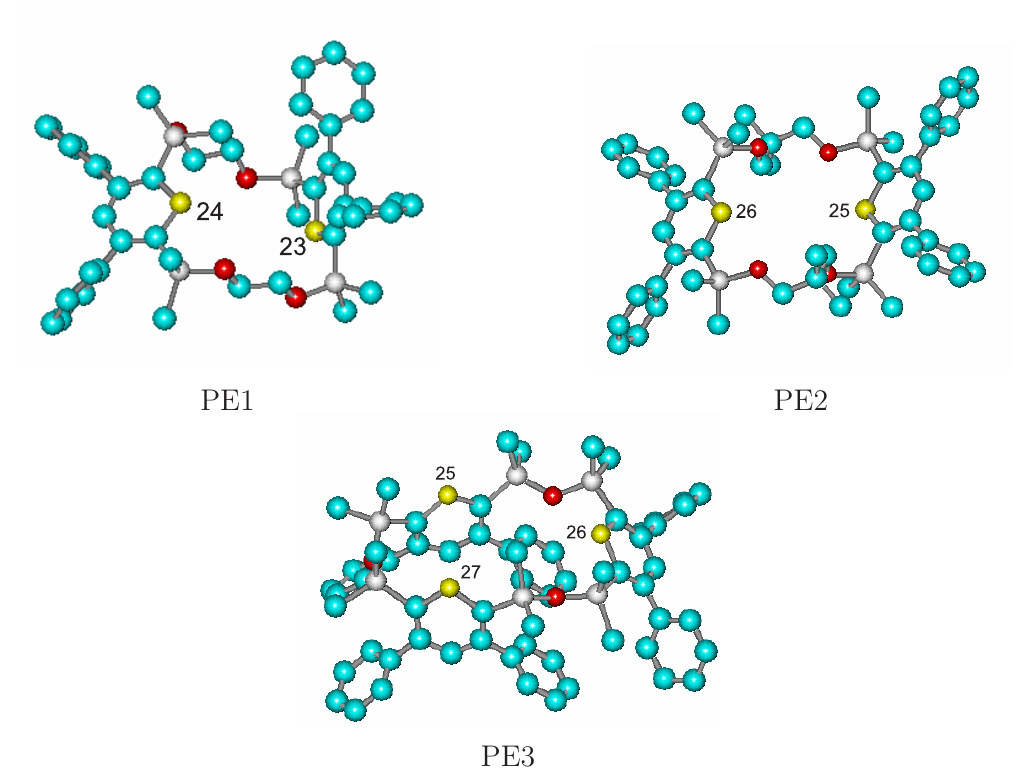
Fig. 2 Equilibrium geometries of phosphinine-ether macrocycles resulted from PM3 calculation.